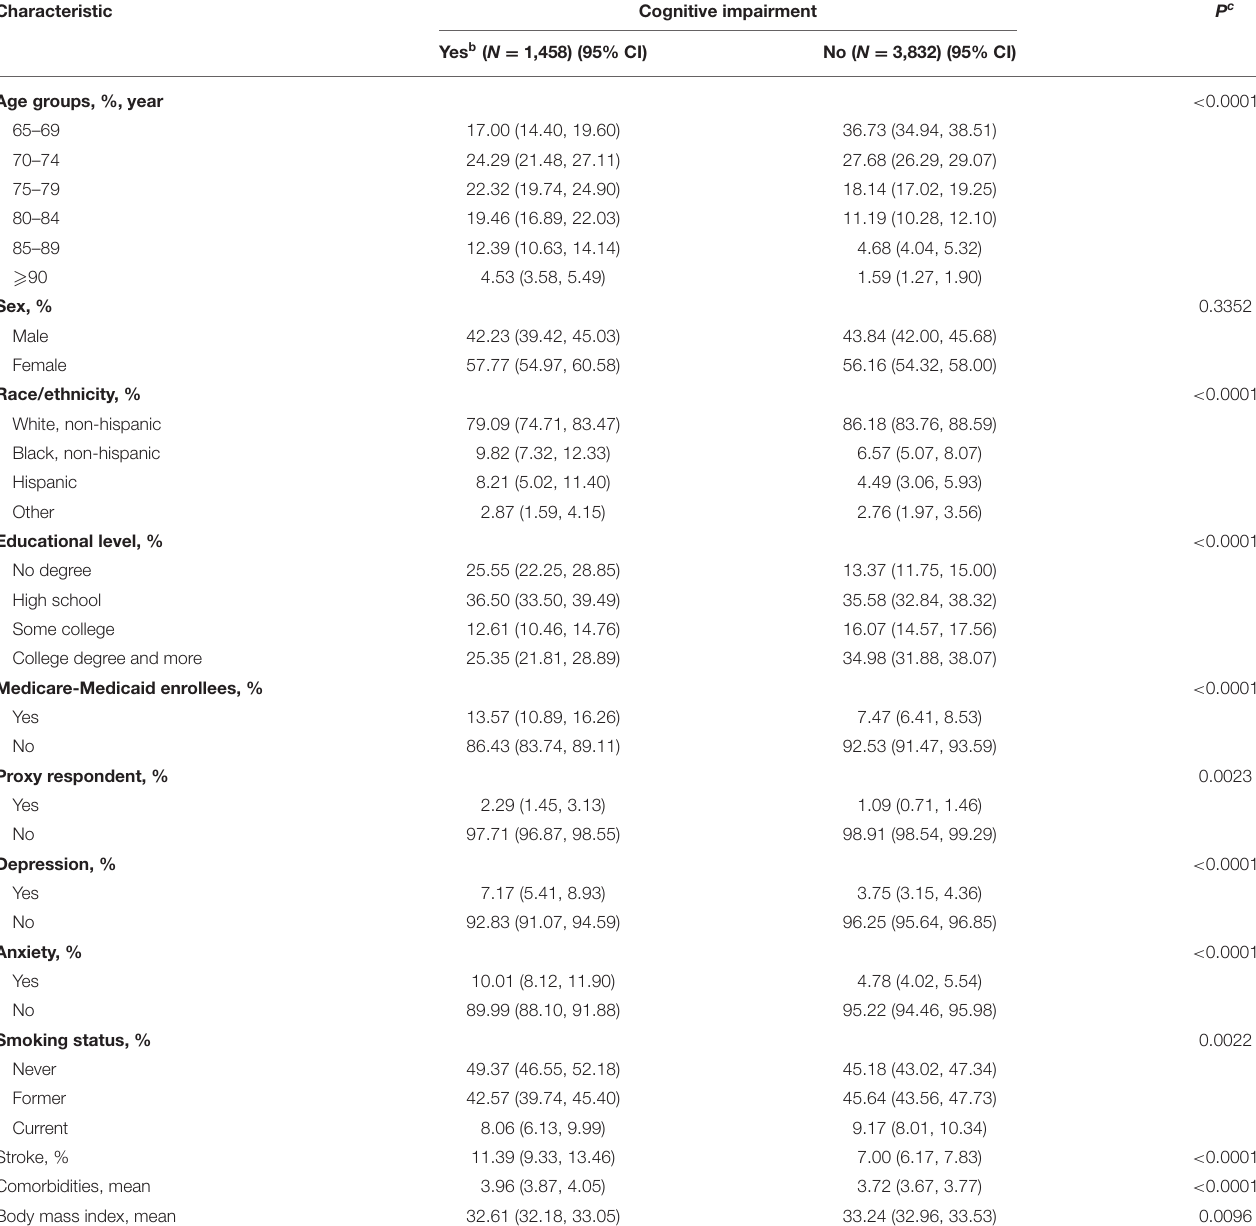
TABLE 1 | Weighted sample characteristics and comparisons stratified by cognitive impairment during the 8 years of follow-up a .